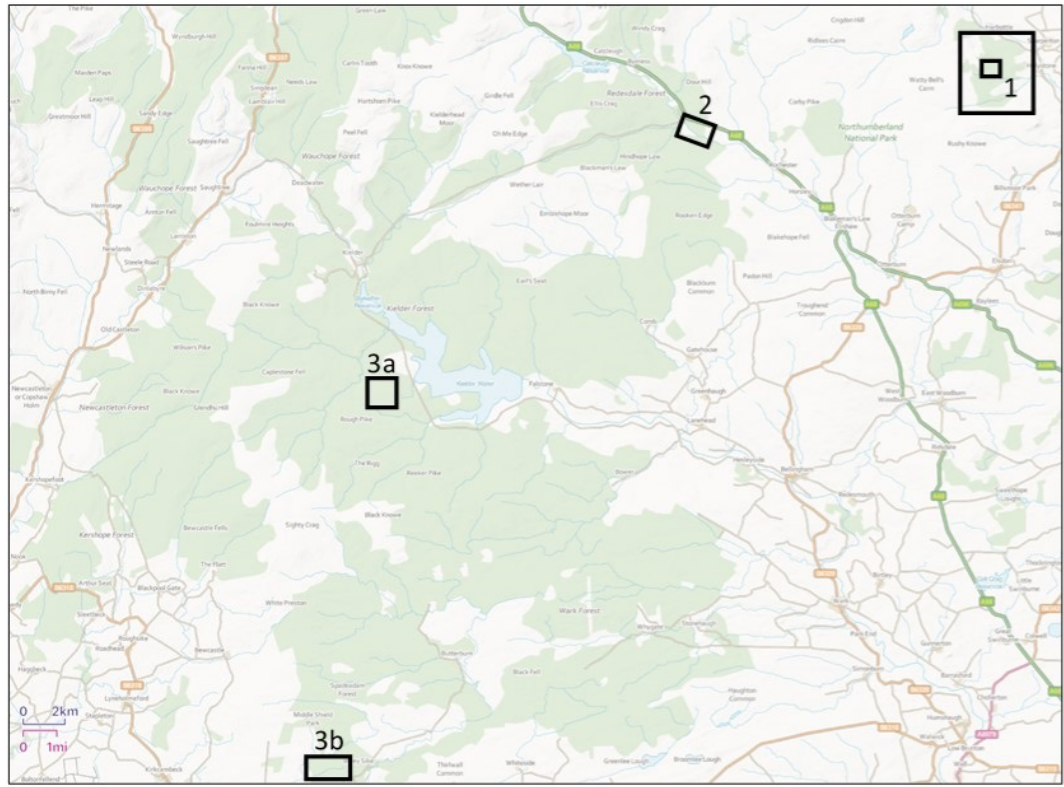
Figure 1. Location of sampling sites. Site 1 (inner square) identifies the Holystone main sampling area, and Site 1 (outer square) identifies the Holystone wider sampling area (from which roe deer, fungal fruiting body, berry and some vegetation samples were collected). Site 2 identifies the Kielder main sampling area. Sites 3a and 3b identify the Kielder deer sampling areas (and those of the associated fungal fruiting body and some vegetation samples); note that site 3b is referred to as Spadeadam in Barnett et al. (2020). Contains Ordnance Survey data © Crown copyright and database right